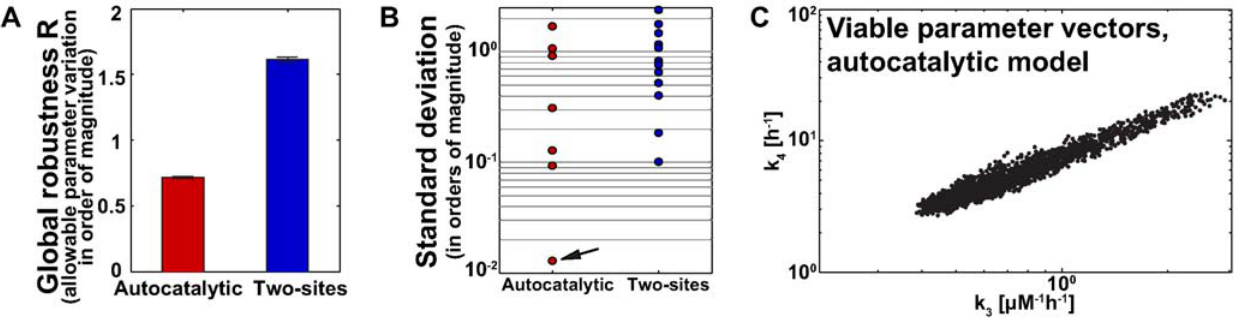
Figure 3. Results of the global robustness analyses for both models. (A) The two-sites model (right) has significantly greater nomalized viable volume than the autocatalytic model (left). Error bars ( v 1% ) correspond to standard deviations over five independent estimates. (B) Standard deviations along the principal axes of viable parameters for the autocatalytic model and the two-sites model. Note the logarithmic scale. The autocatalytic model has a strongly constrained axis (arrow); amounts of variation along the other axes are overall smaller for the autocatalytic model. (C) Projection of the viable vectors of the autocatalytic model after the MC integration on the plane ( k 3 , k 4 ) . These two parameters are strongly correlated resulting in the lowest standard deviation for the autocatalytic model